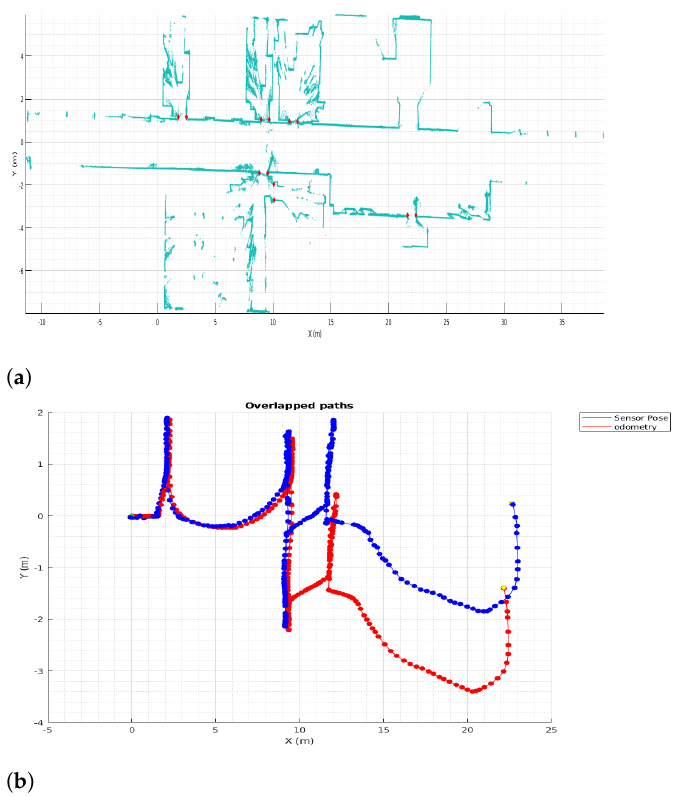
Figure 8. 2D HS-SLAM. ( a ) 2D HS-SLAM results. ( b ) Odometry and Lidar